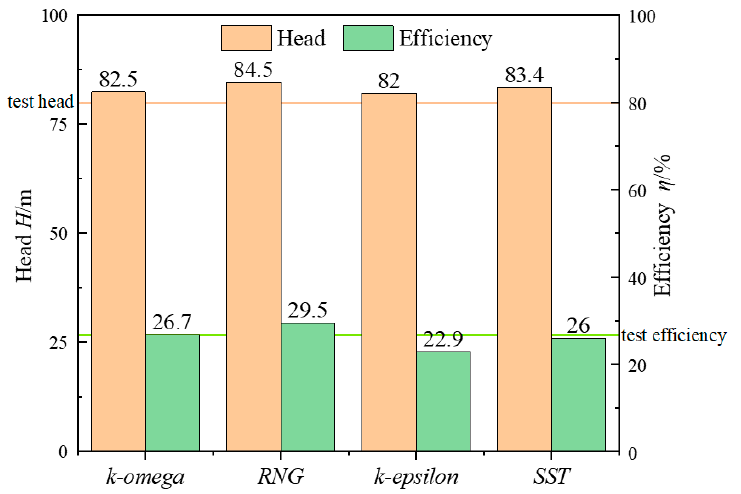
Figure 5. Comparison of computational fluid dynamics (CFD) results and test results of different turbulence models.